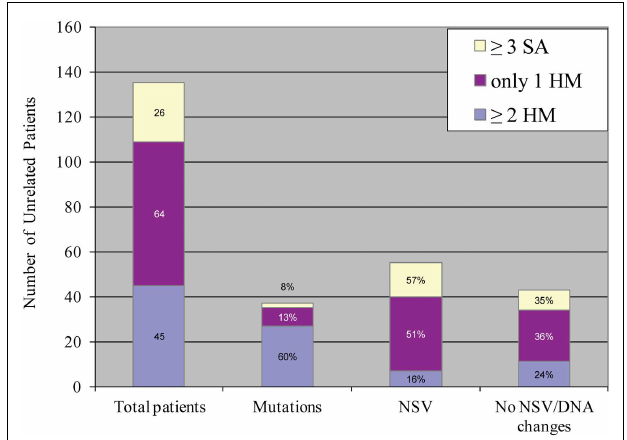
FIGURE 5 | Summary of NLRP7 mutation and non-synonymous variants found in 135 unrelated patients with varying histories of reproductive wastage . HM stands for hydatidiform mole; SA, stands for spontaneous abortion; NSV, for non-synonymous variant. Mutations in NLRP7 were most frequently observed in patients with at least two HMs, followed by patients with one HM, and then by patients with at least three SAs (84).